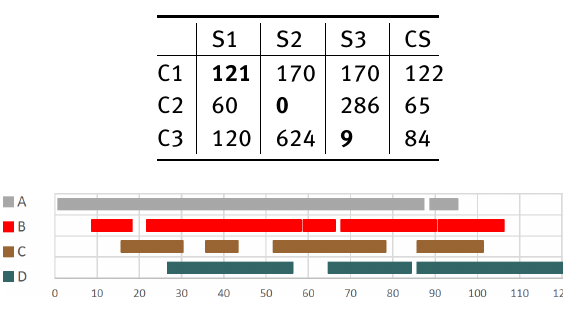
Table 4: Values of individual criteria (C1, C2, C3) for solutions of single-criterion alternative (S1, S2, S3) and a compromise solution (CS) (expressed in days).